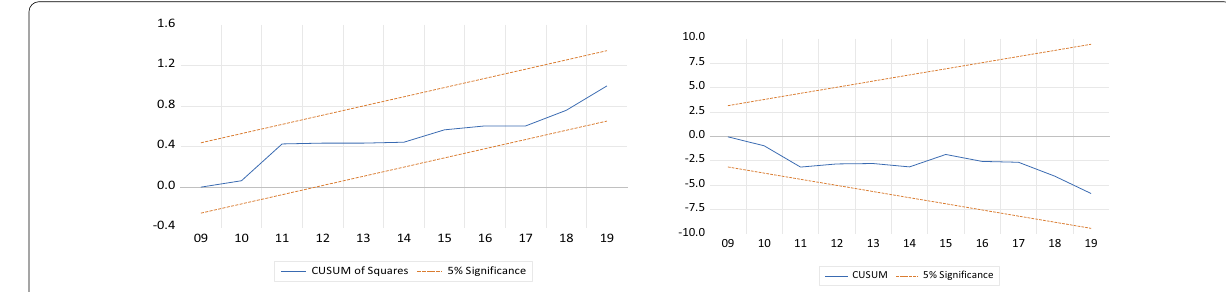
Fig. 2 CSUM of Squares and CUSUM. Source Research finding